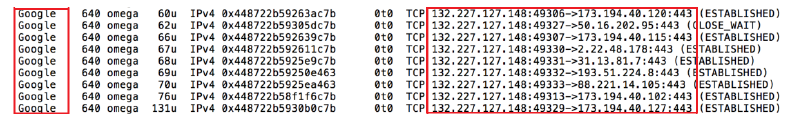
Figure 4. Example of an output of the lsof